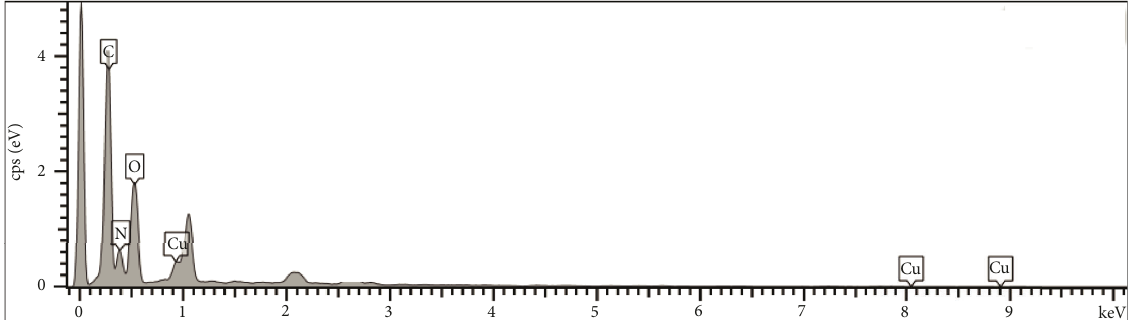
Figure 6: EDX spectra of [Cu( L